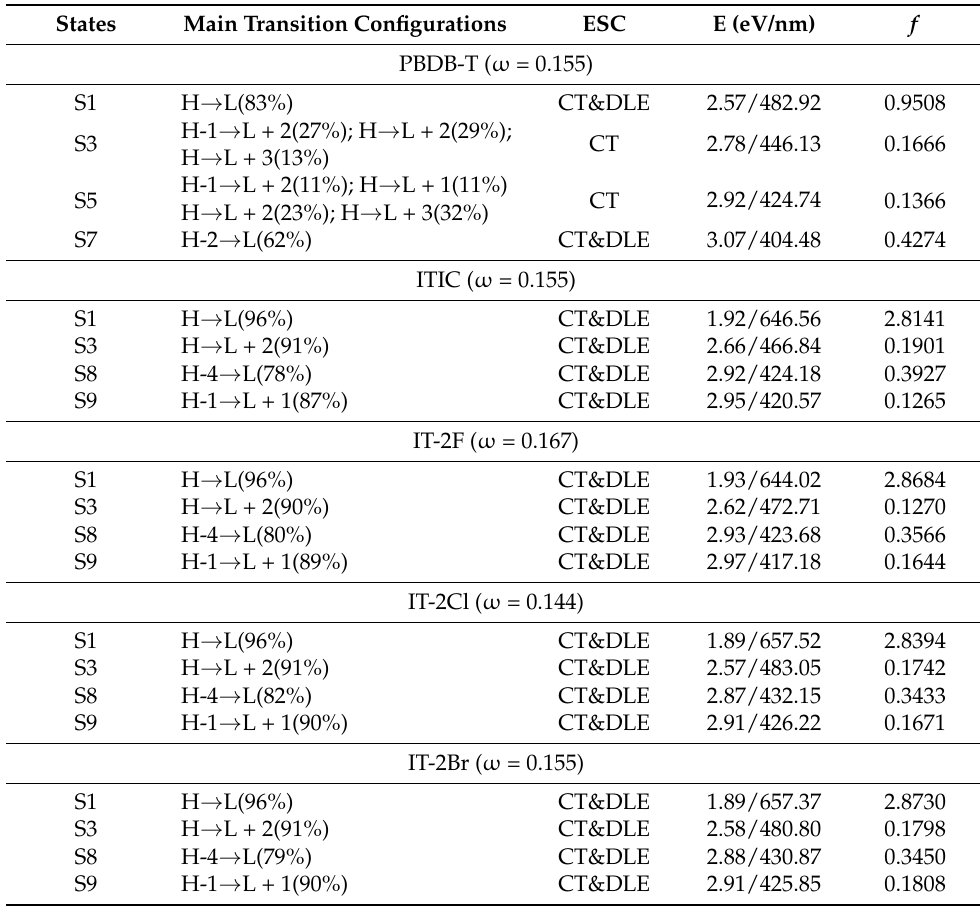
Table 3. The calculated transition energies (in eV), excitation wavelengths (in nm), excited states characters (ESC), corresponding oscillator strengths ( f ), and the main transition configurations with coefficients larger than 10%. CT and ACT represent the charge transfer from the donor segment to the acceptor segment and from the acceptor segment to the donor segment. DLE (ALE) represents the local excitation that occurs on the donor (acceptor) segment. The states with f > 0.1 and excitation wavelength longer than 400 nm are listed (LC-PBE/6-31G**; the ω unit is Bohr − 1 ; α = 0.200, β = 0.086; ε s = 3.5, ε d =